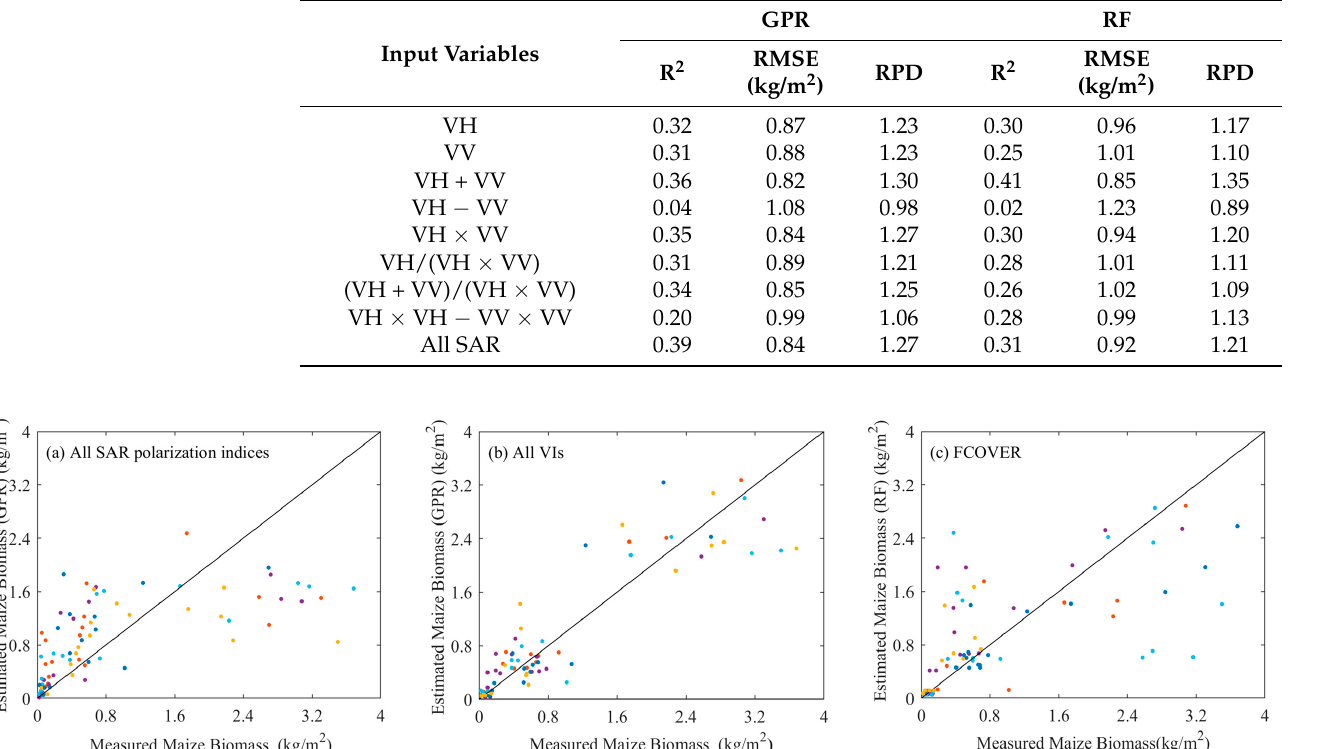
Table 3. Performance of S-1 SAR polarization indices on estimating maize biomass based on GPR and RF.